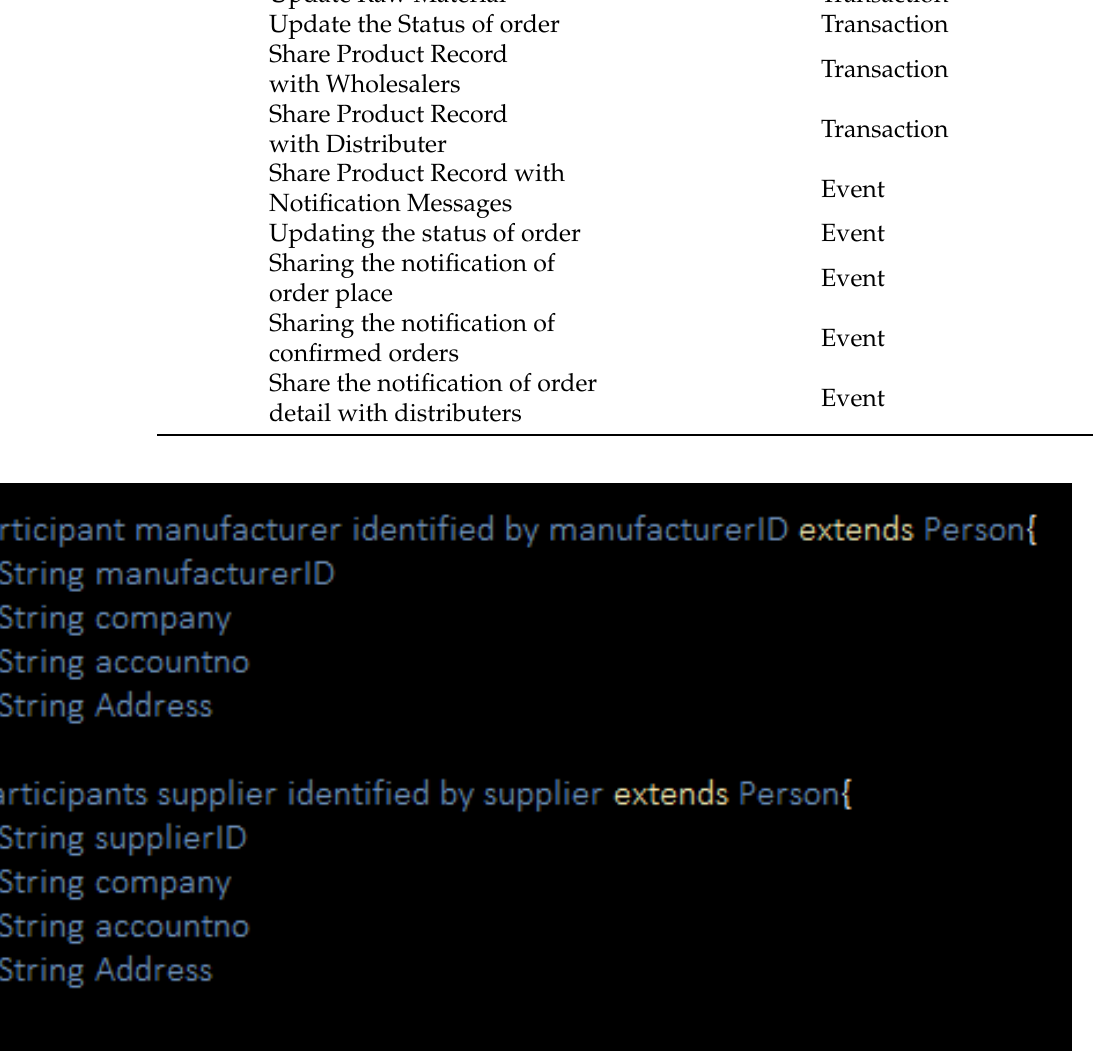
Figure 8. Definition of Hyperledger composer